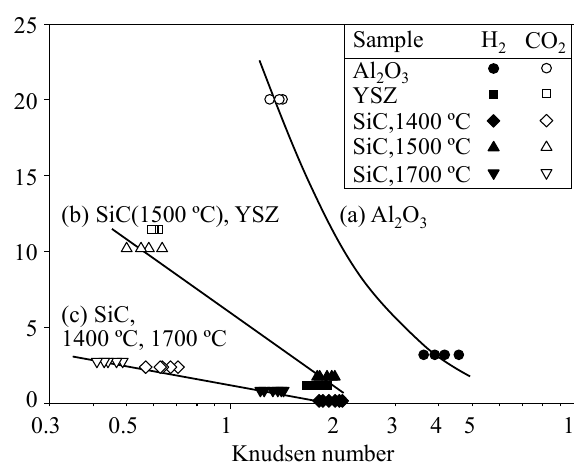
Figure 10. Relationship between the critical pressure gradient and the Knudsen number for ( a ) Al 2 O 3 , ( b ) YSZ and SiC sintered at 1500 °C, and ( c ) SiC sintered at 1400 °C and 1700 °C.